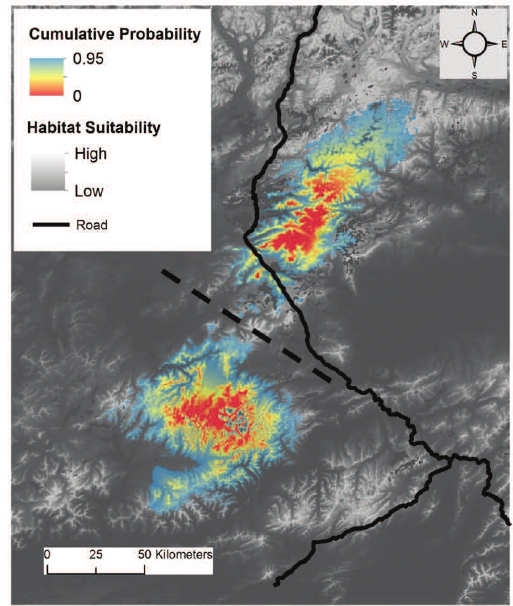
Figure 6. Habitat suitability index and cumulative prob- ability (note: low cumulative probability translates to high probability of use) of aggregate home ranges (averaged in- dividual utilization distributions) for RMH (southwest of dotted line) and HHH (northeast of dotted line) in central